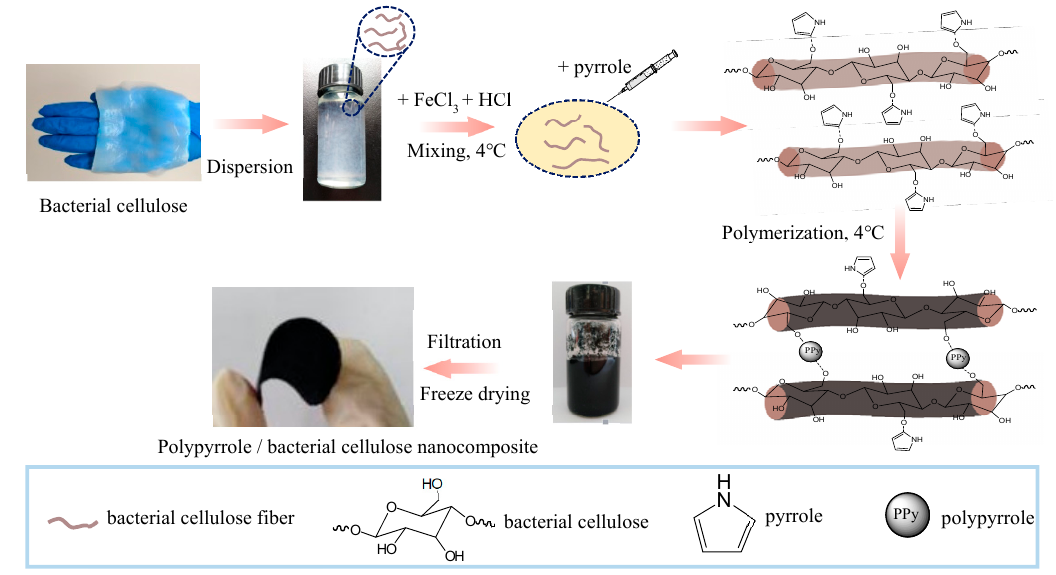
/ BC nanocomposite. Figure 1. Schematic illustration of preparation PPy/BC nanocomposite. Figure 1. Schematic illustration of preparation PPy Table 2. Response surface design matrix with experimental and predicted